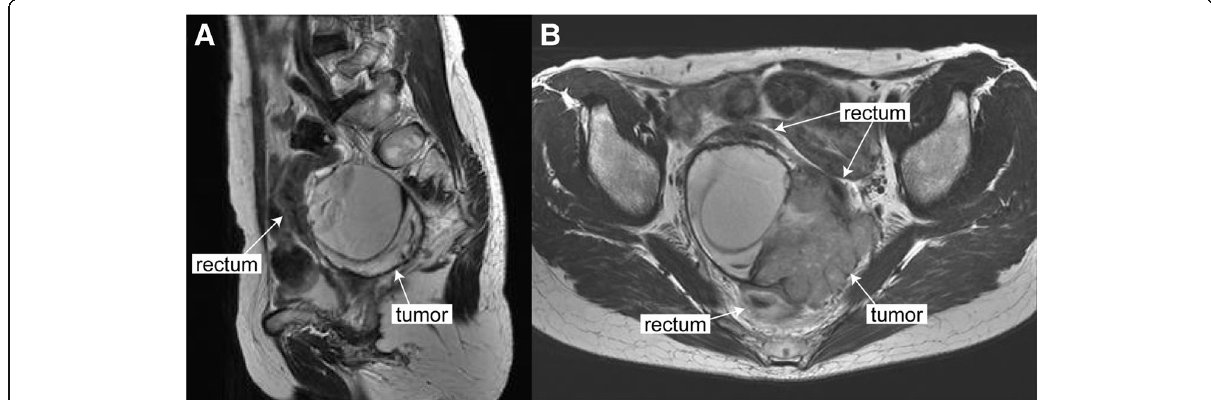
Fig. 1 Preoperative T2-weighted magnetic resonance imaging showed the pelvic mass composed of cystic and solid parts in a axial and b sagittal views. Arrowheads indicate the tumor and rectum in each